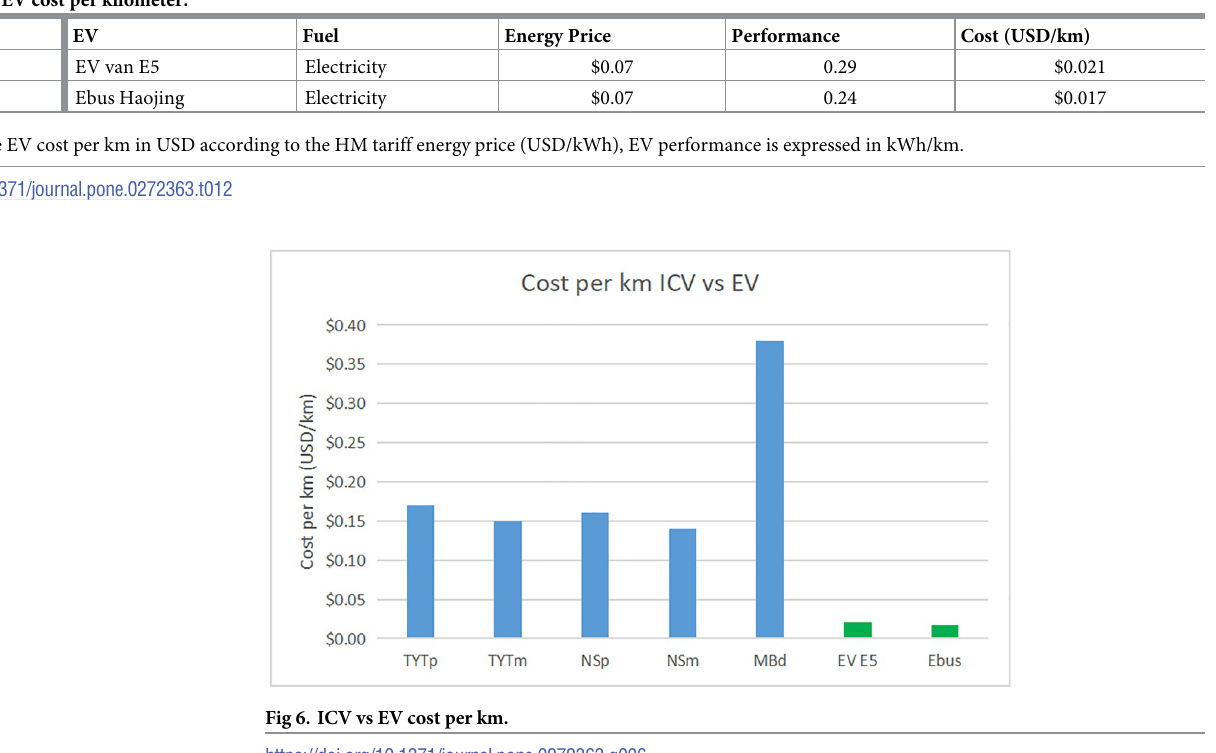
Table 12. EVs cost per kilometer. Energy price and EV cost per kilometer.